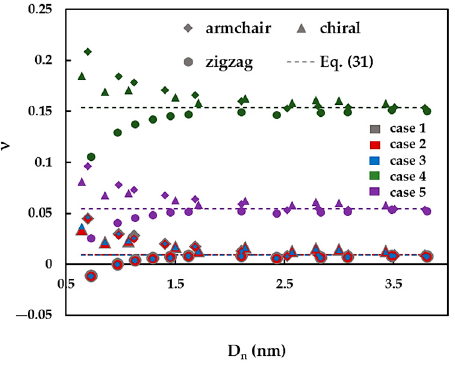
Figure 12. The evolution of the Poisson’s ration, ν , with the nanotube diameter, D n , for